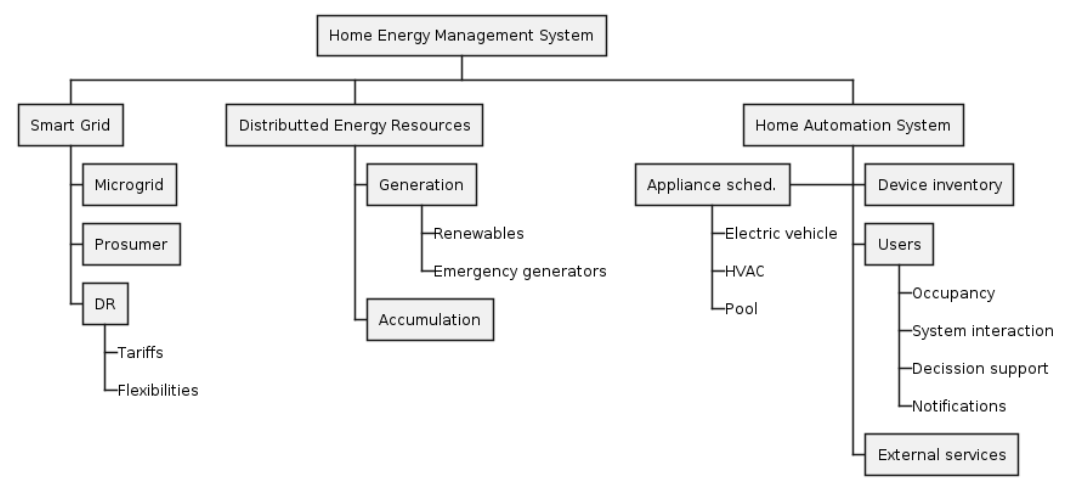
Figure 2. Home energy management